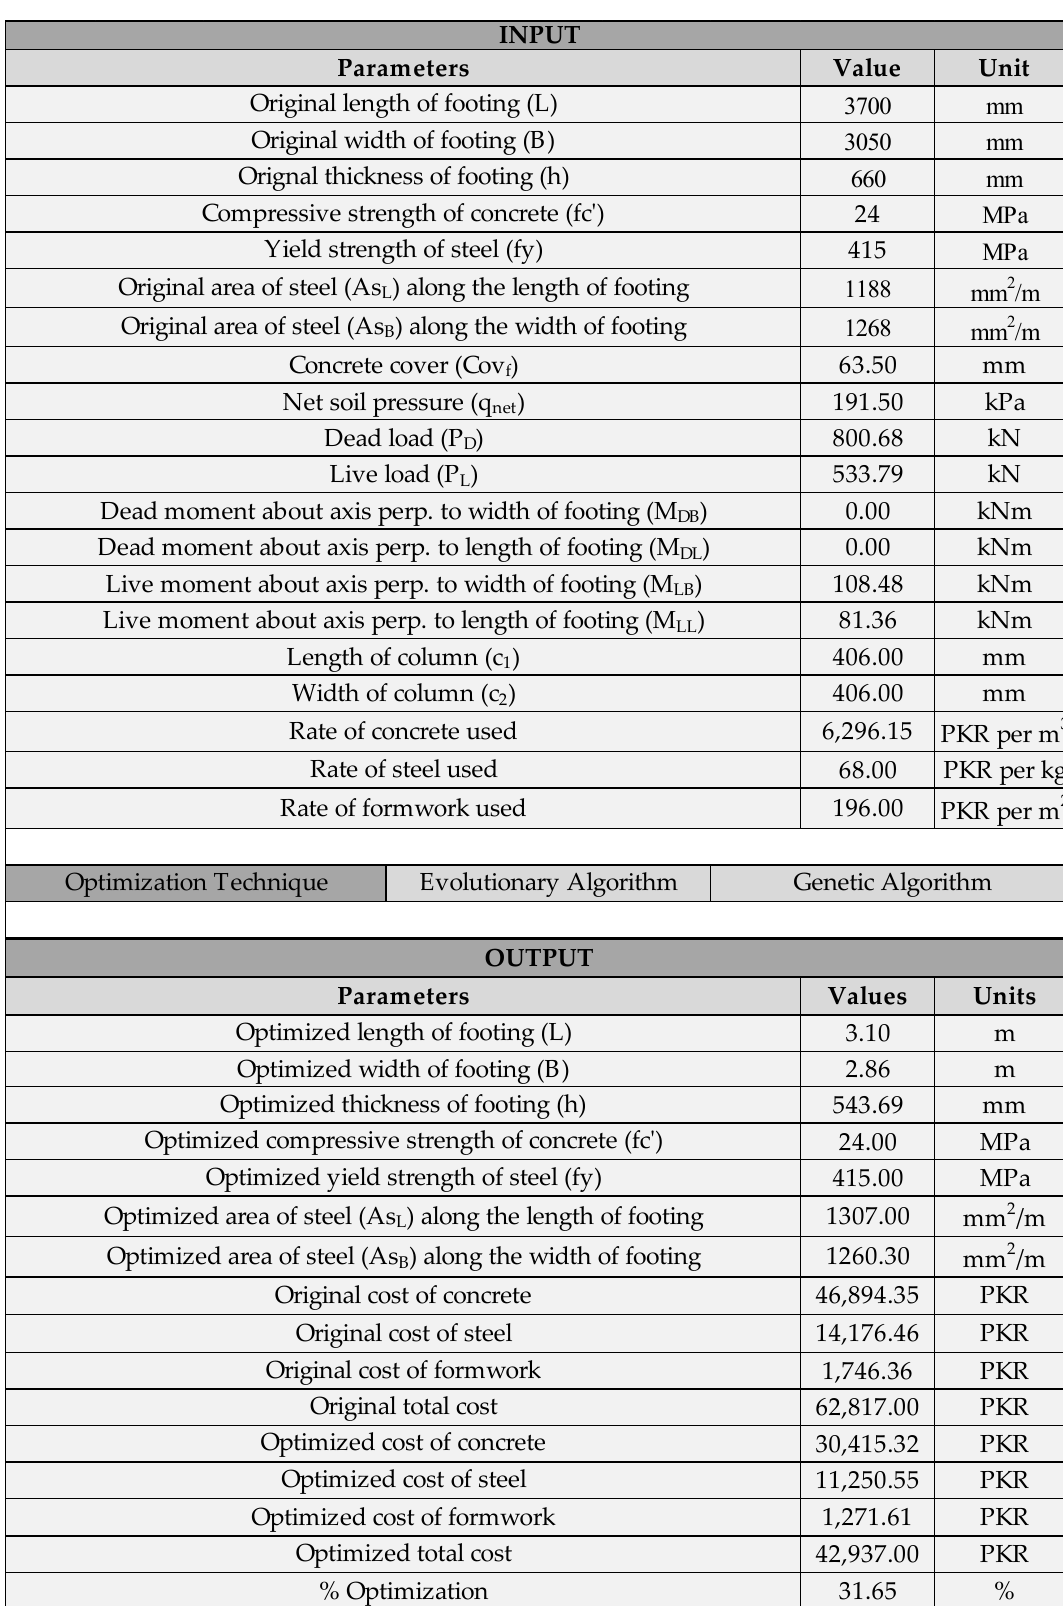
Figure 5. Spreadsheet-based interface for the developed optimization tool.